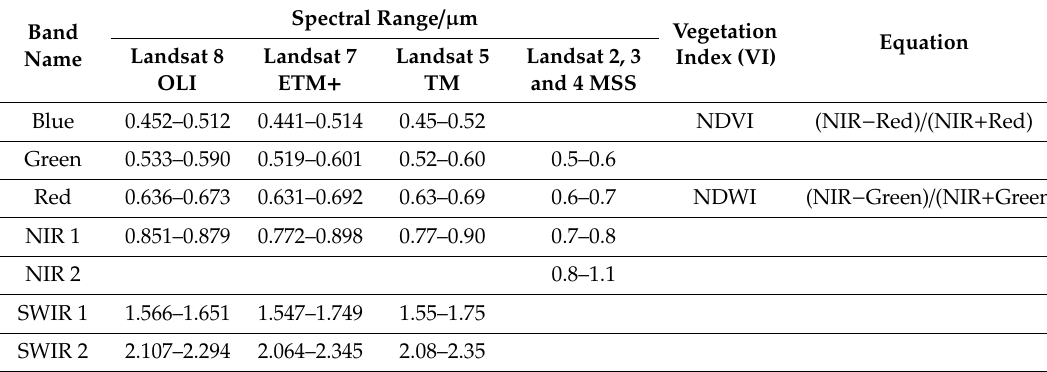
Table 1. Characteristics of multitemporal Landsat series data used in the